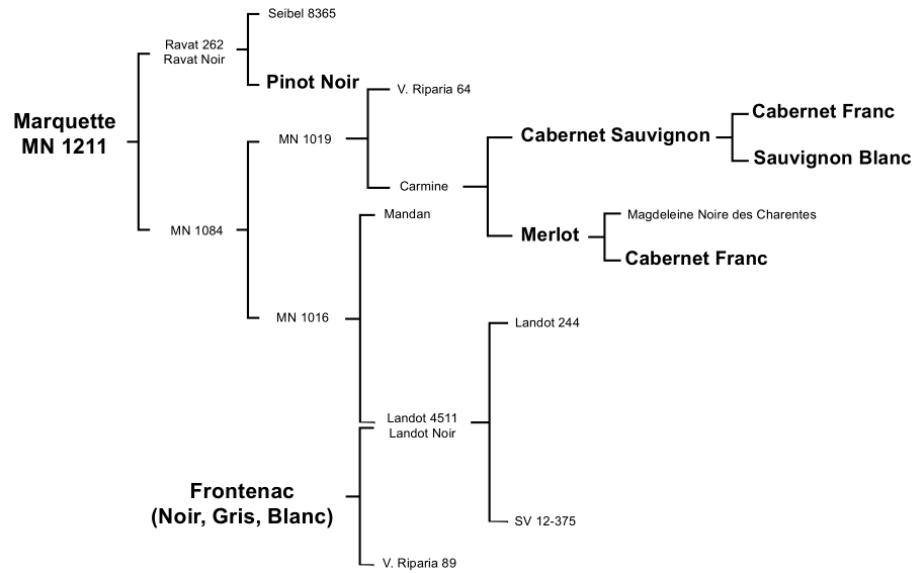
Figure 1. Pedigree of Frontenac and Marquette cultivars. Parentage of Marquette includes Pinot Noir, Cabernet Sauvignon, Merlot, Cabernet Franc, and Sauvignon Blanc. Marquette and Frontenac share common parentage (about 70%). This figure is adapted from pedigree maps from Chateau Stripmine [31,32].